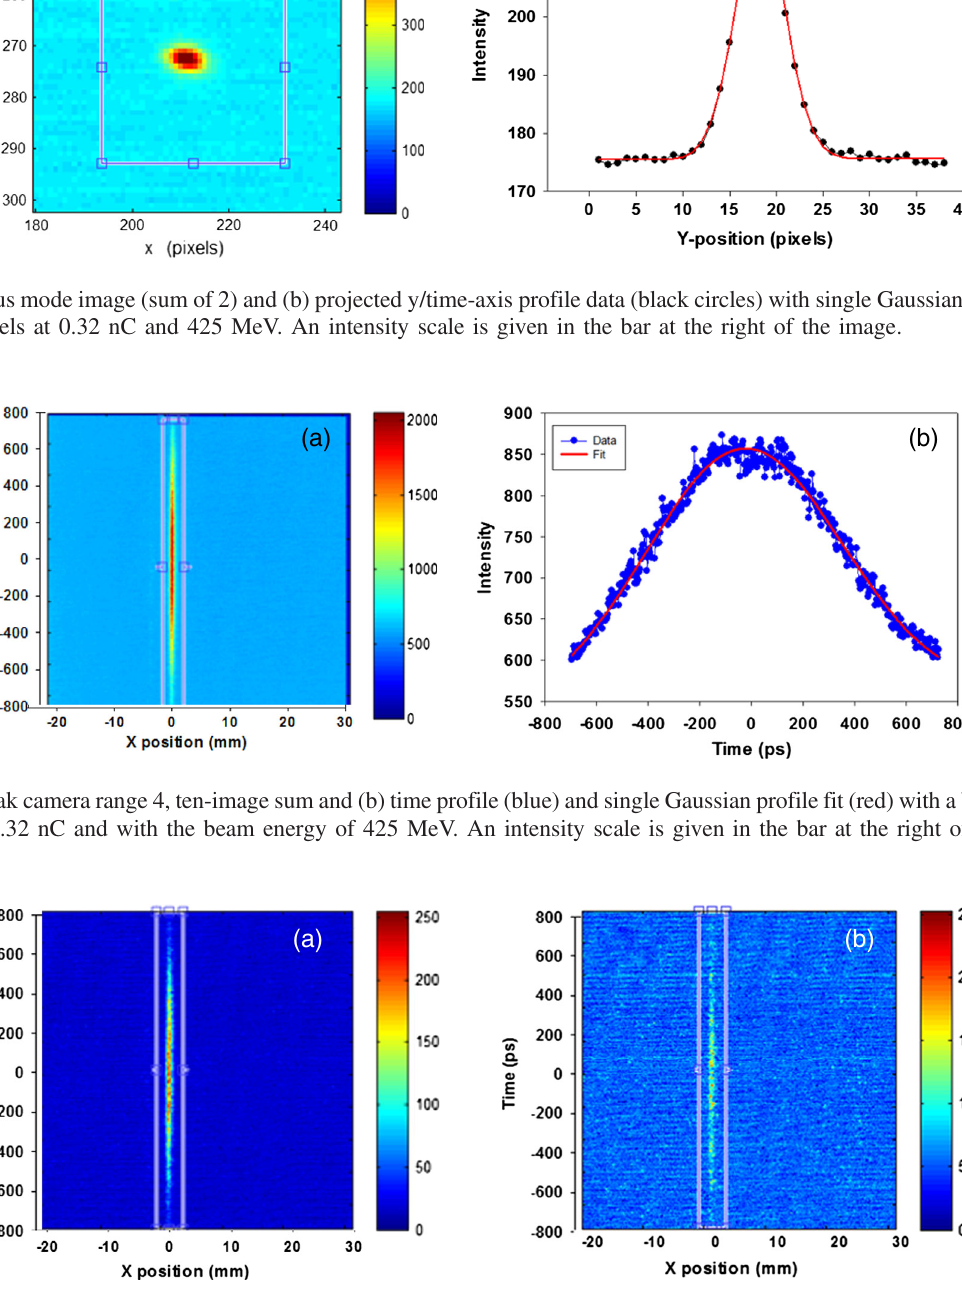
FIG. 8. Streak camera sum image (200 images) at 425 MeV for (a) 389 e − and (b) 57 e − circulating in the ring. The projected time profile with the single Gaussian peak fit gives the bunch lengths σ t ¼ 354 (cid:3) 12 and 276 (cid:3) 36 ps, respectively. The digitizer background noise adds to the variance in (b). An intensity scale is given in the bar at the right of each